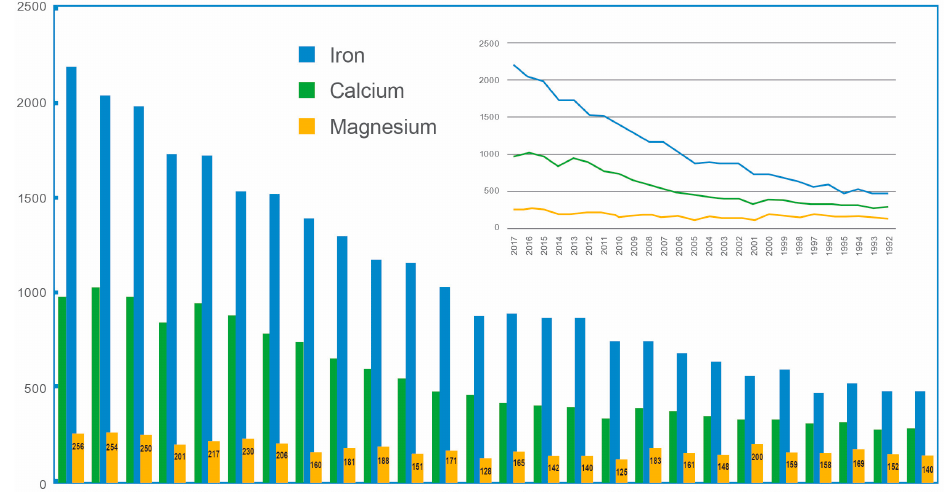
Figure 1. Number of basic and clinical research papers published (Y-axis) as screened using Web of Science [v.5.28.1] under the search terms “magnesium deficiency” (yellow), “calcium deficiency” (green) or “iron deficiency” (blue) (performed 4 May 2018) over the past 25 years (X-axis; 2017–1992). (Inset) Trend lines show the relatively flat research output on magnesium deficiency relative to calcium and iron.